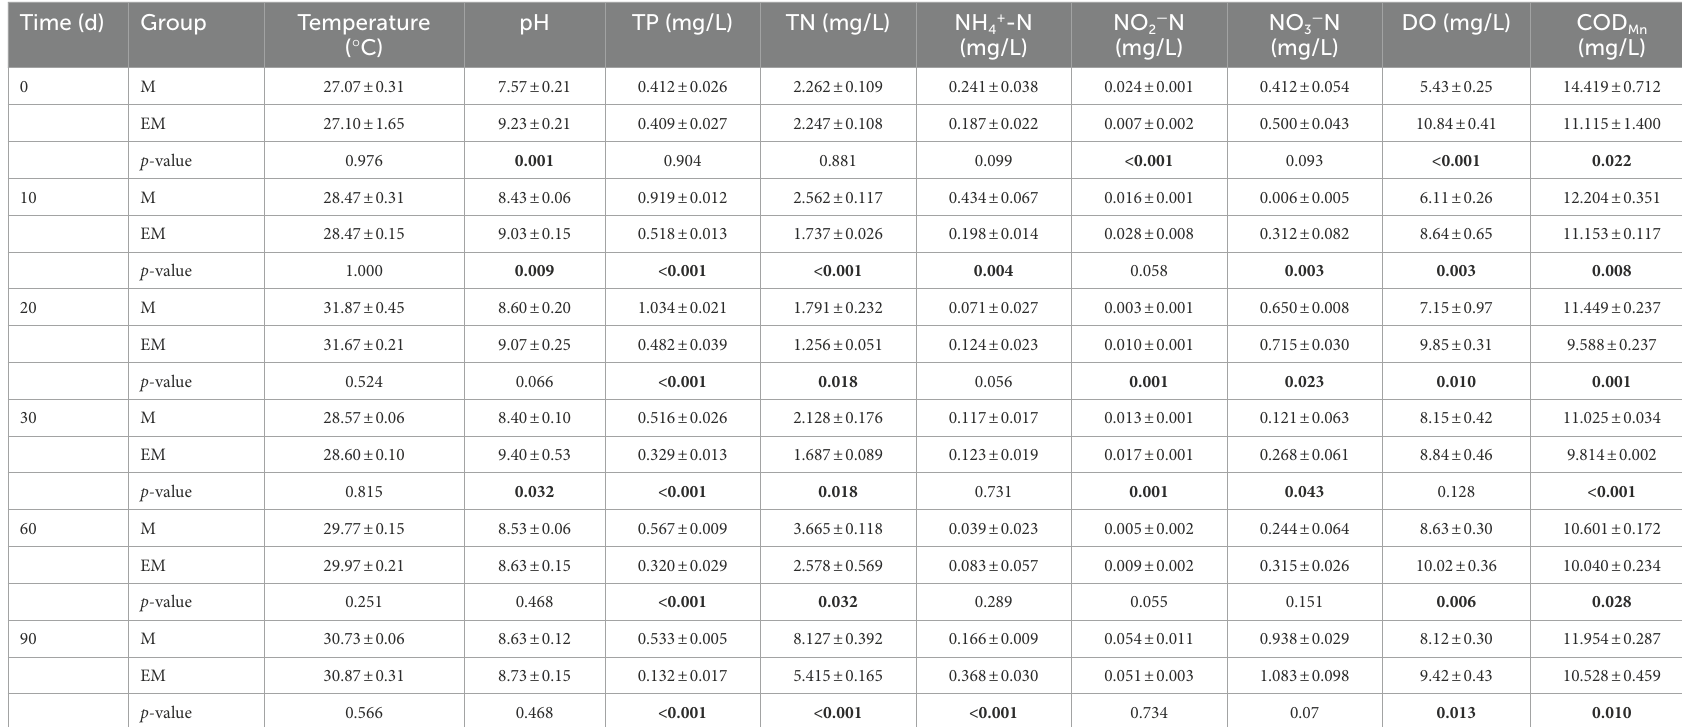
TABLE 2 Physicochemical parameters of water in M and EM